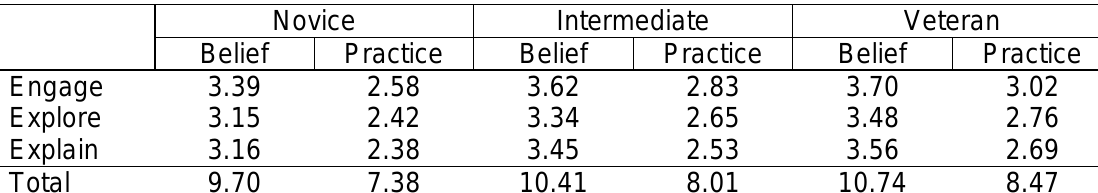
Comparison of facilitator mean scores with regard to inquiry learning belief versus practice.